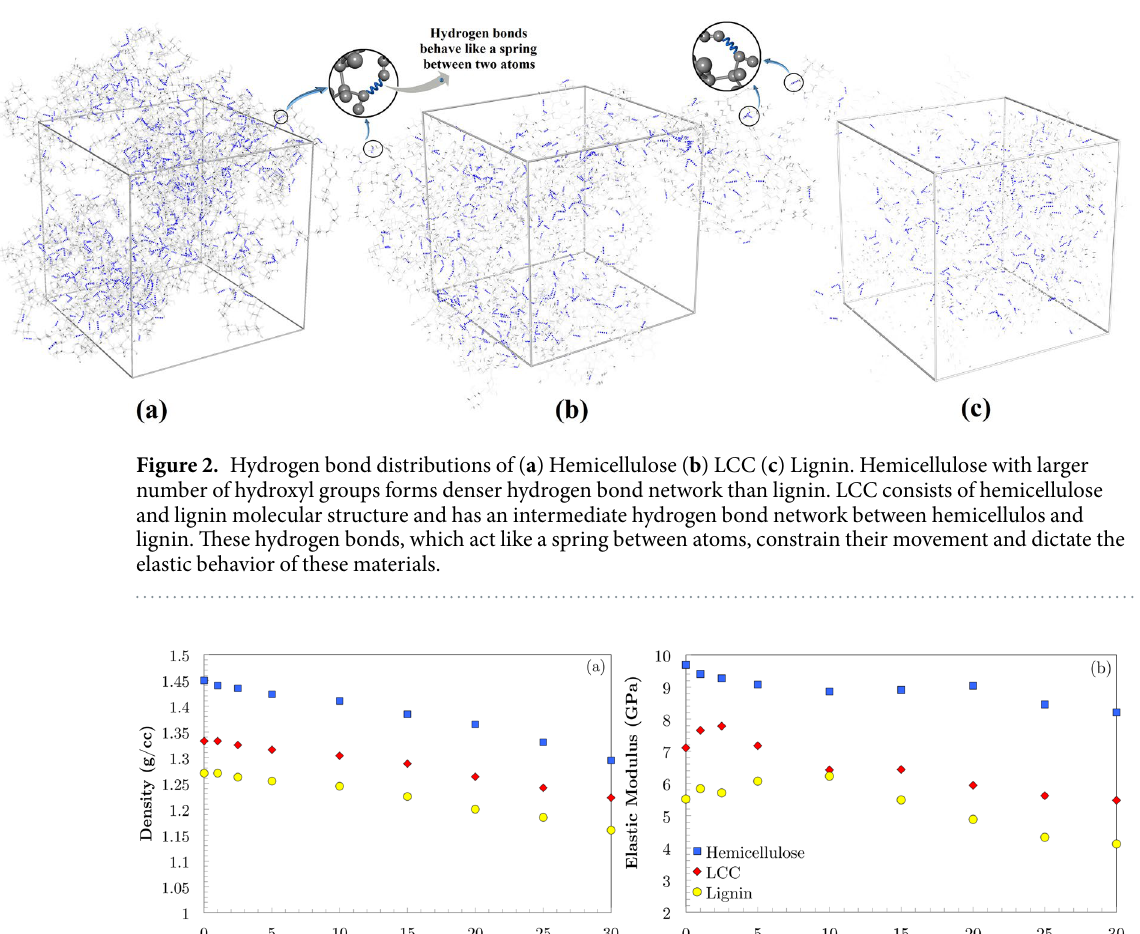
elastic moduli increase at low water content (less than 10%) and decreases afterwards. The peaks in elastic moduli are at 2.5% and 10% MC for LCC and lignin, respectively. When water molecules permeate into the polymer, they enhance the elastic modulus of the material. Once the number of water molecules inside the material reaches a certain level, the effect of water molecules becomes regressive and the modulus of elasticity starts to decrease. Comparison between the shapes of the moisture-dependent elastic moduli from the nanoindentation exper- iments (Fig. 1) and simulation results (Fig. 3b) reveals interesting similarities. The transverse nanoindentation elastic moduli have a similar shape to the hemicellulose simulations and the longitudinal nanoindentation elastic moduli have similar shape to the LCC and lignin simulations. This suggests that the nanostructure of fiber is organized in such a way that when compressed in the direction perpendicular to the cellulose microfibrils, hemi- cellulose, or possibly the similarly structured amorphous cellulose, has more influence on the elastic response than lignin. Conversely, in the direction parallel to the cellulose microfibrils the lignin has a larger effect than the hemicellulose on the elastic response. The intermolecular energies between particles in a material play an important role in determining its molecu- lar structure that intimately dictates the physical properties such as density and elastic modulus. Since hydrogen bond interactions are both short range and angle-dependent, their impacts on structuring of polymers are signif- icant. In hemicellulose and lignin, due to their high number of hydroxyl groups, the consequences of hydrogen bond energies are amplified, especially when interacting with water molecules. Studying variation of hydrogen bonds with water content allows us to capture important physics of water-polymer interactions with a minimal need for experimental inputs. Hence, we start with investigating the total hydrogen bond energies of hemicellu- lose, LCC and lignin in different MC (Fig. 4a). All three materials exhibit almost the same progressive trend of total hydrogen bond energies when the water content increases. Nevertheless, hemicellulose shows higher total hydrogen bond energy than LCC and lignin due to the larger number of hydroxyl groups.